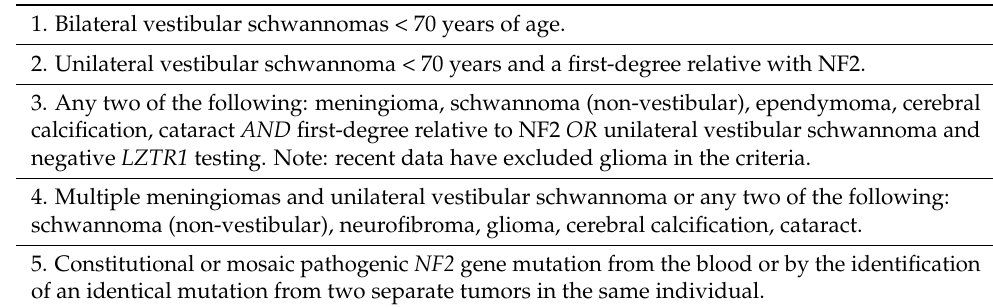
Table 1. Clinical diagnosis criteria for neurofibromatosis type 2 (NF2)